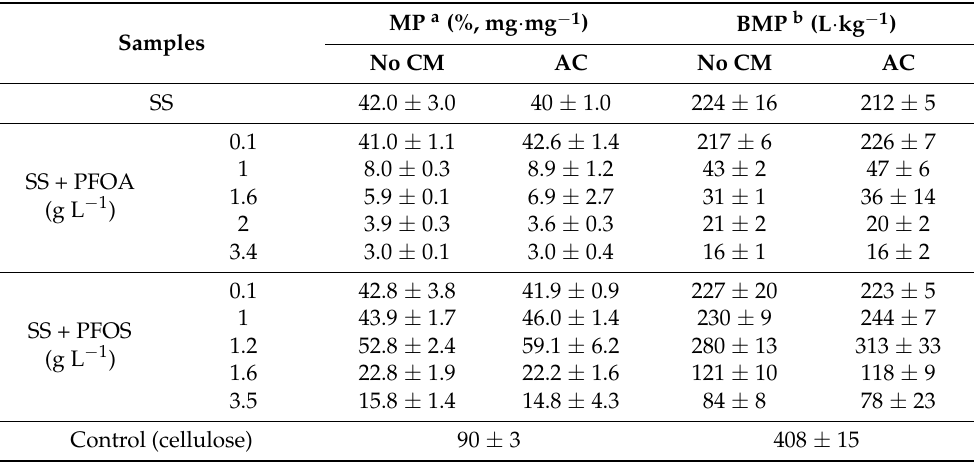
Table 5. Methanization percentage (MP) and biochemical methane potential (BMP) from SS contami- nated with PFOA and PFOS in the presence and absence of 0.1 g L − 1 AC.